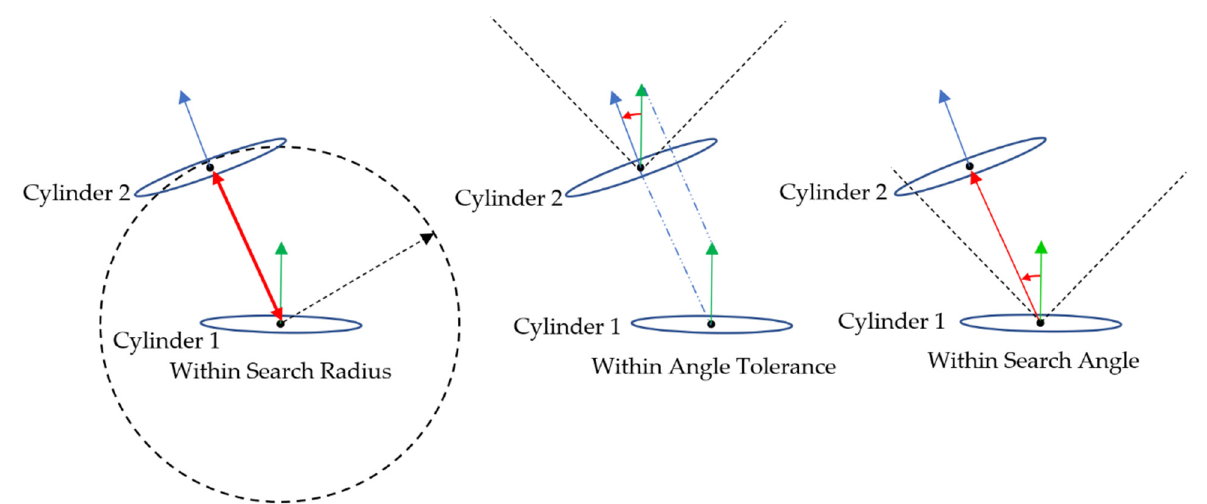
Figure 6. Three main rules are used to determine if points are to be grouped as the same tree in this step. First (Left), all other cylinders within a search sphere of Cylinder 1 are found. All of these cylinders are then checked against two angle-based rules using the angle between the two major axis vectors (angle tolerance), and the angle between the translation vector from Cylinder 1 to Cylinder 2, and the major axis vector of Cylinder 1 (search angle).